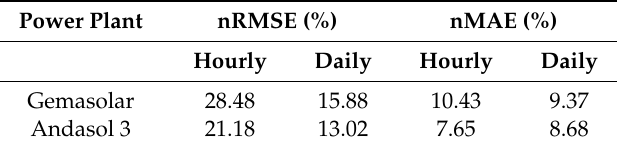
Table 3. Hourly and daily values of normalized root mean square error (nRMSE) and mean absolute error (nMAE) for the estimated total electric energy to the grid outputs, obtained from the 19.9 MW e Gemasolar and the 50 MW e Andasol 3 SAM simulations (E P and E G , respectively). The E P and E G simulated values are based on the same hourly dataset (DNI and meteorological data) of forecasted and measured input parameters acquired for É vora, for the same period of study (from 1 July 2017 to 30 June